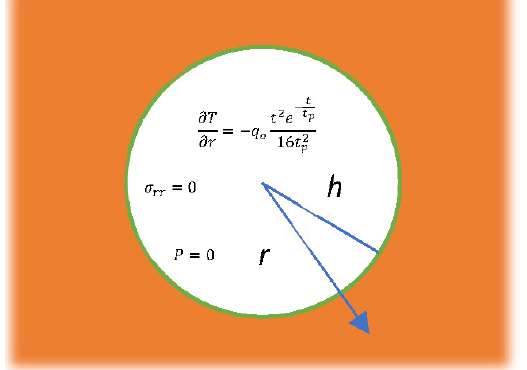
Figure 1. The sketch of an unbounded medium containing a spherical cavity.